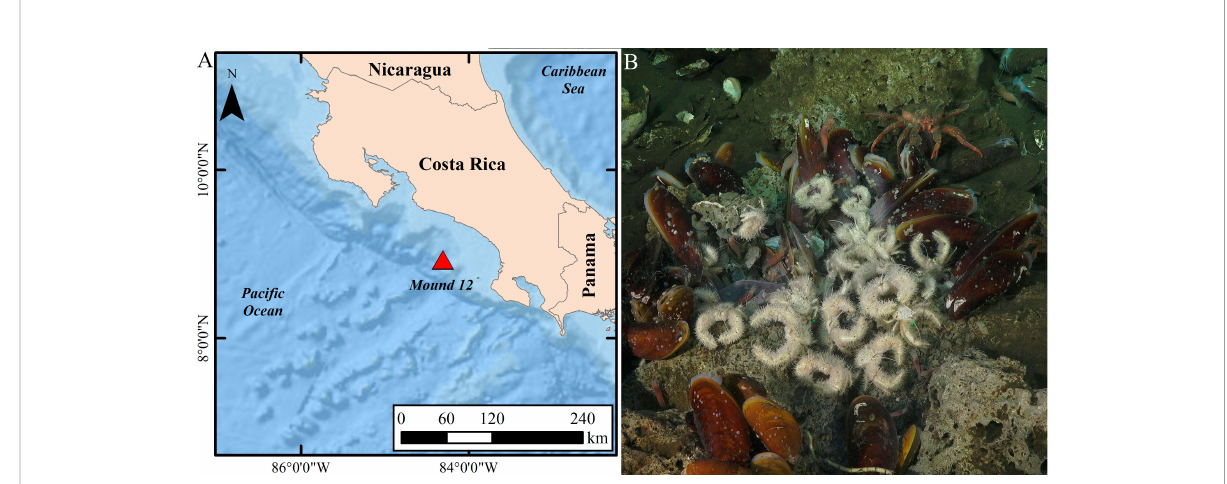
FIGURE 1 Sampling location (A) and detail of the yeti crabs Kiwa puravida (B) at Mound 12, a methane seep at ~1,000 m deep on the Costa Rican Paci fi c